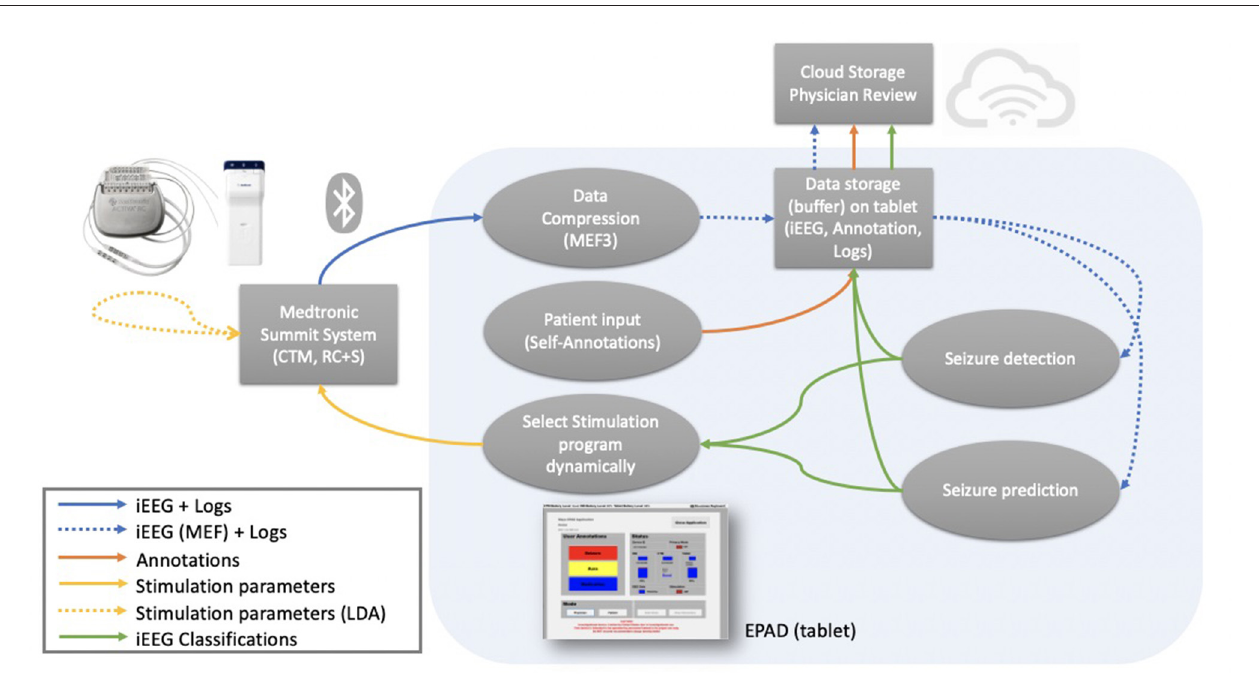
FIGURE 2 | Data flow—Data flow between the different parts of the EPAD system. Colored arrows represent different data types flow. Blue (solid): data packets and logs from the from the investigational Medtronic Summit RC + S TM are compressed. Blue (dashed): compressed iEEG data and logs are stored in a cloud-synchronized repository and used as input for the complex electographic seizure detection and prediction algorithms. Orange: patient-generated annotations are stored in a cloud-synchronized repository. Green: iEEG classifications from the electographic seizure detection and prediction algorithms are stored in a cloud-synchronized repository. Yellow (solid): stimulation parameters modulation based on EPAD iEEG classifications. Yellow (dashed): stimulation parameters modulation based on the embedded detector seizure